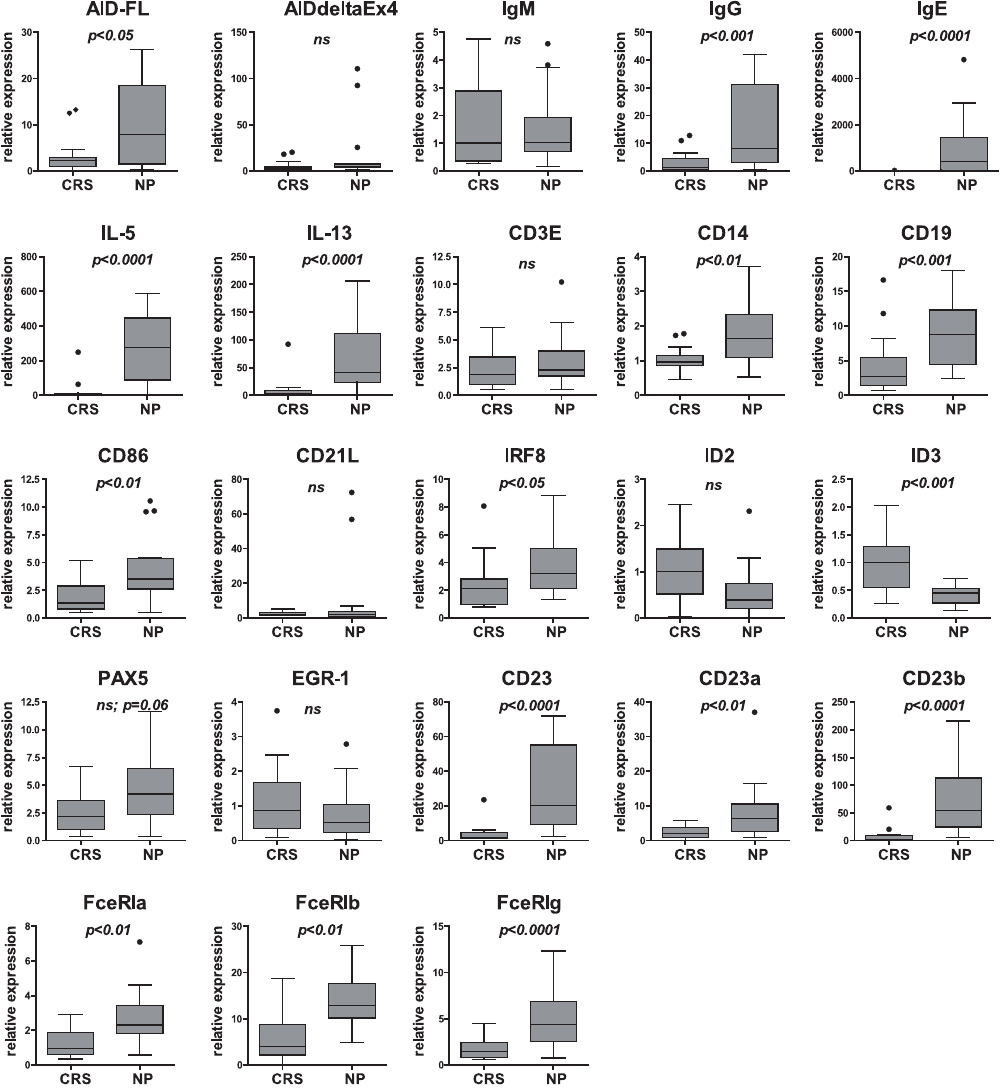
Figure 3. Differential expression of AID-associated genes in specimens with nasal polyps (NP) in comparison to the one without nasal polyps (CRS). (A) Box-plot analysis of gene expression profiling dataset of CRS (n=15) and NP (n=18) specimens. The box represents the distribution of values; a line across the box represents the median; the box stretches from the lower hinge (the 25th percentile) to the upper hinge (the 75th percentile). p value is shown for each gene (t test for log2 values of variances). All modulated genes with the significant difference between two diseased groups, including AID, passed the Holm-Bonferroni correction for multiple testing.